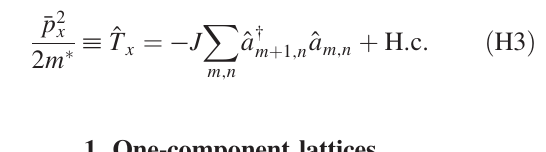
Table I defines all the lattice operators used in Sec. VI.